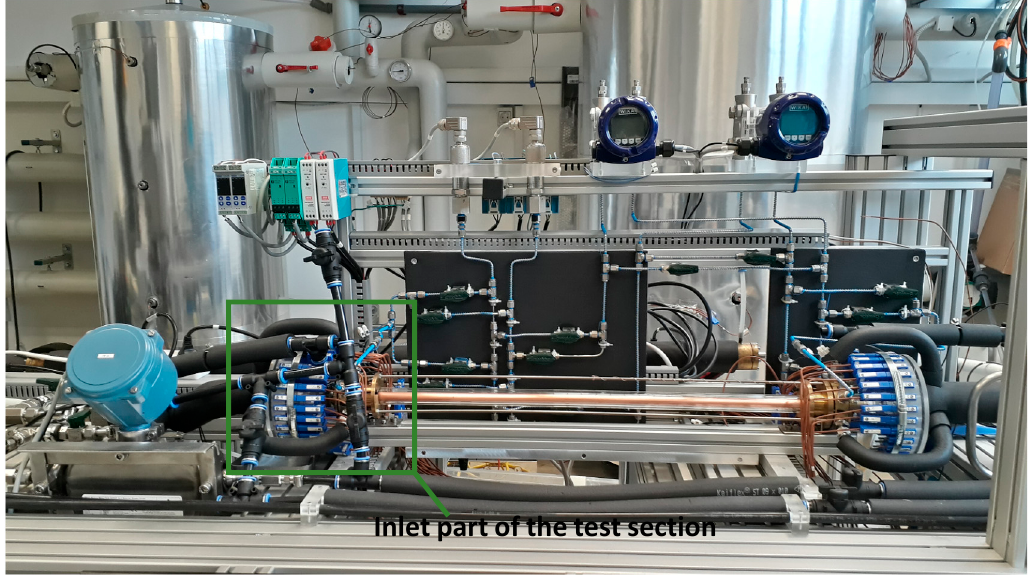
Figure 1. Experimental setup in laboratory THELMA.